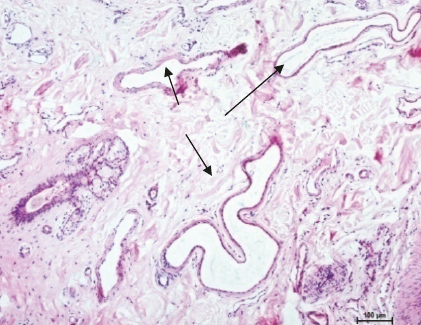
Figure 7: Photomicrographs from abdomen lateral region of skin showing sweat glands (arrow). Hematoxylin and eosin X 100.